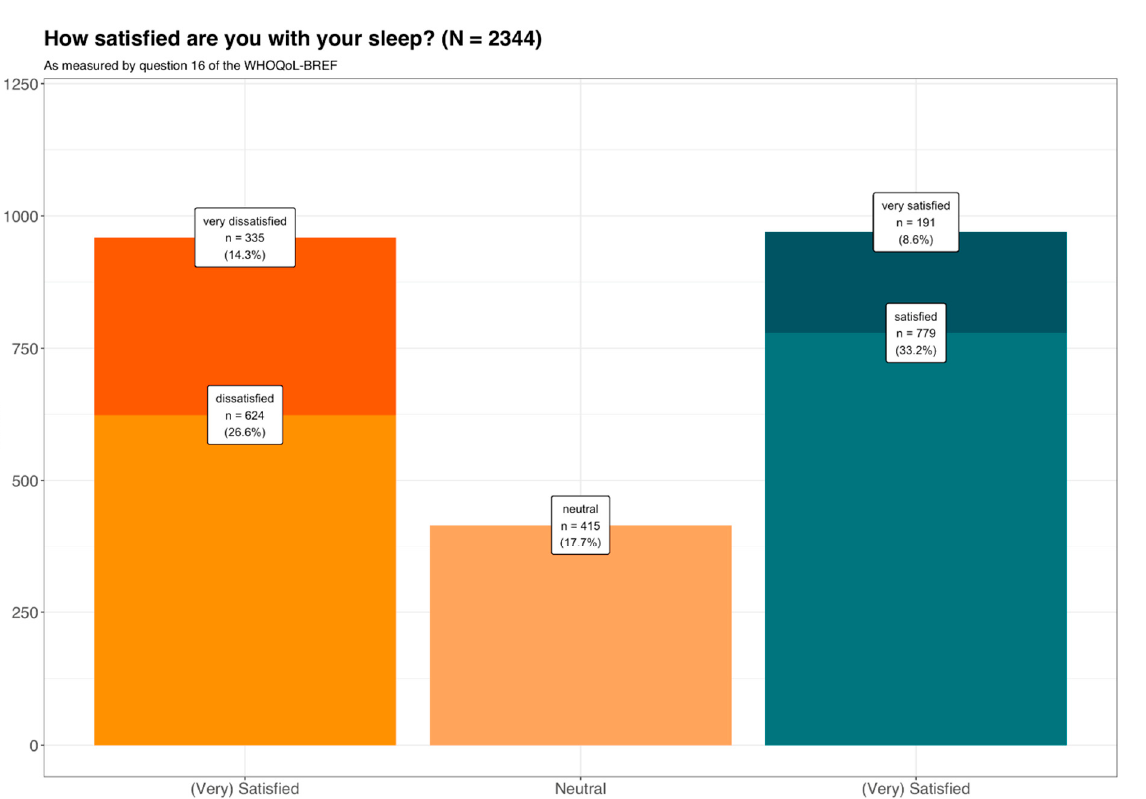
Figure 1. The distribution of sleep satisfaction. The groups very dissatisfied and dissatisfied with sleep, as well as the groups satisfied and very satisfied with sleep were grouped together yielding three groups that were used as response variable: (very) dissatisfied with sleep, neutral, and (very) satisfied with sleep. Table 1. Demographics of the study sample ( n = 2344), stratified according to the patient’s reported sleep satisfaction as measured by question 16 of the Bref-WHOQOL (see methods). p -values were corrected for multiple comparisons using the Holm method [58].